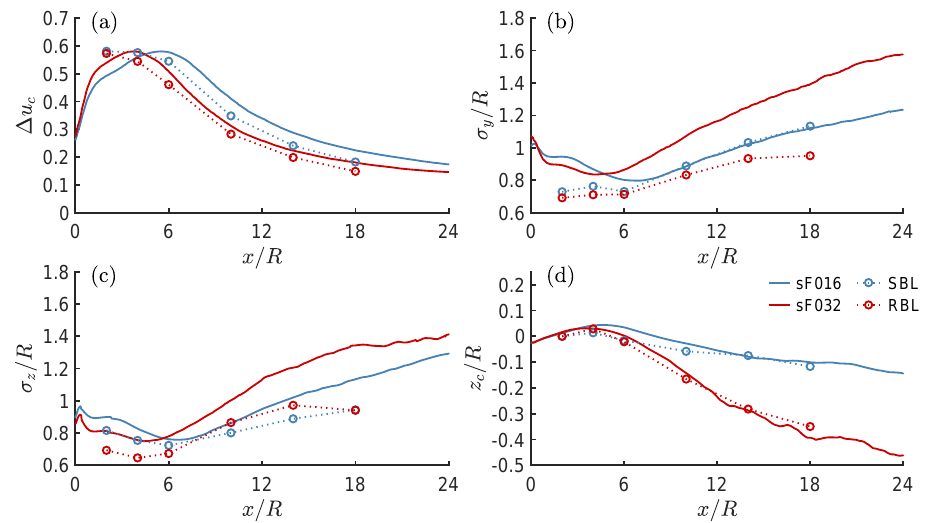
Figure 15. Wake parameters of the model wind turbine operating at design tip − speed ratio above moderate (SBL) and high (RBL) ground roughness: ( a ) centerline velocity deficit ∆ u C , ( b ) lateral σ y and ( c ) vertical half width σ z , and ( d ) vertical centerline position z C . The legend indicates the flow